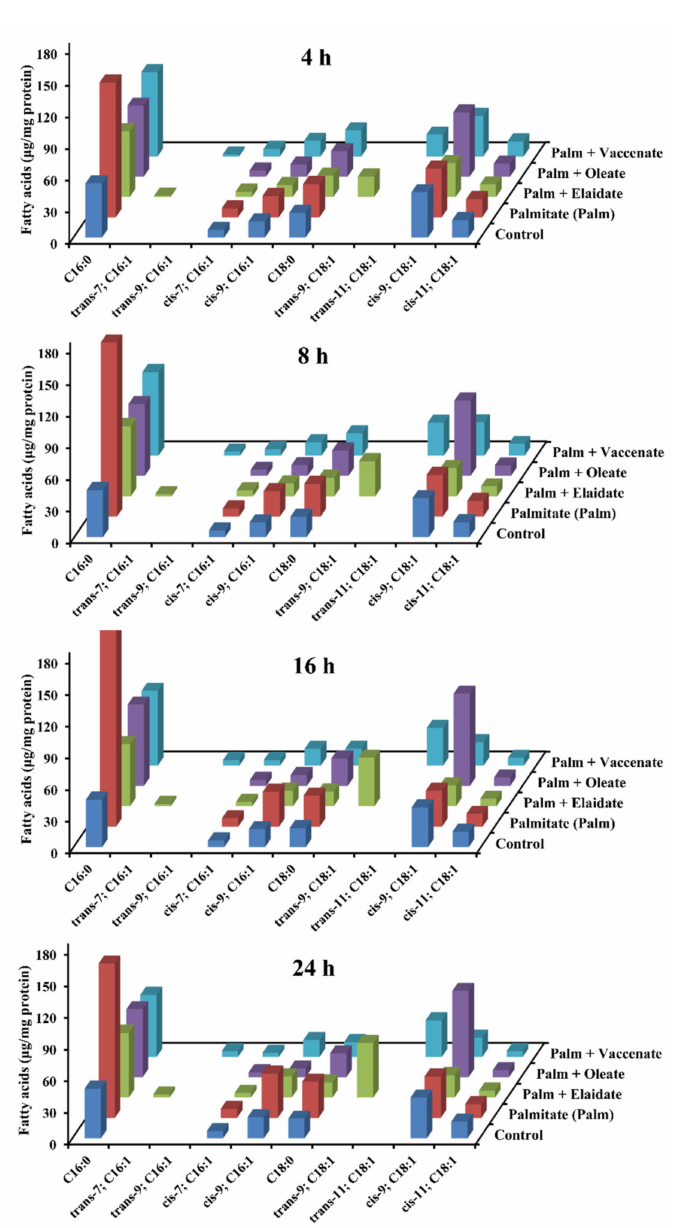
Figure 4. Fatty acid profile. Cells were treated with BSA (control cells) or BSA-conjugated palmitate alone, or with palmitate and one of the unsaturated fatty acids, elaidate, oleate or vaccenate at 250 µ M individual concentration for 8 h at 70%–80% confluence. Washed cell samples were withdrawn at 4, 8, 16 and 24 h times of incubation, and the amounts of ten di ff erent saturated and monounsaturated fatty acids were measured by GC-FID after saponification and methylation. Data were normalized to the protein content of the samples, and are shown as mean values of three independent experiments with two